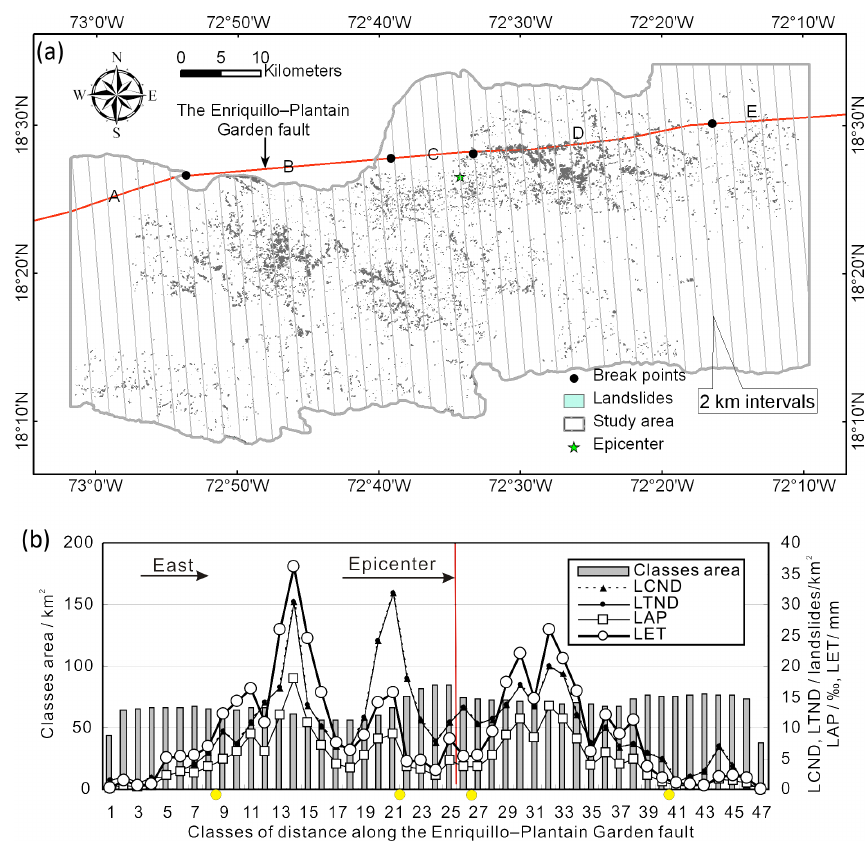
Figure 24. (a) Segments of the Enriquillo–Plantain Garden fault and 2km bands for classifying distance along the fault. A: Miragoâne segment, B: Goave segment, C: Dufort segment, D: Momance segment, and E: Dumay segment. (b) Relation of co-seismic landslides and distance along the Enriquillo–Plantain Garden fault are also presented. In all, 47 classes with 2km intervals were analyzed, and the epicenter is located between classes 25 and 26. The yellow points represent the boundaries of the five segments of the Enriquillo–Plantain Garden